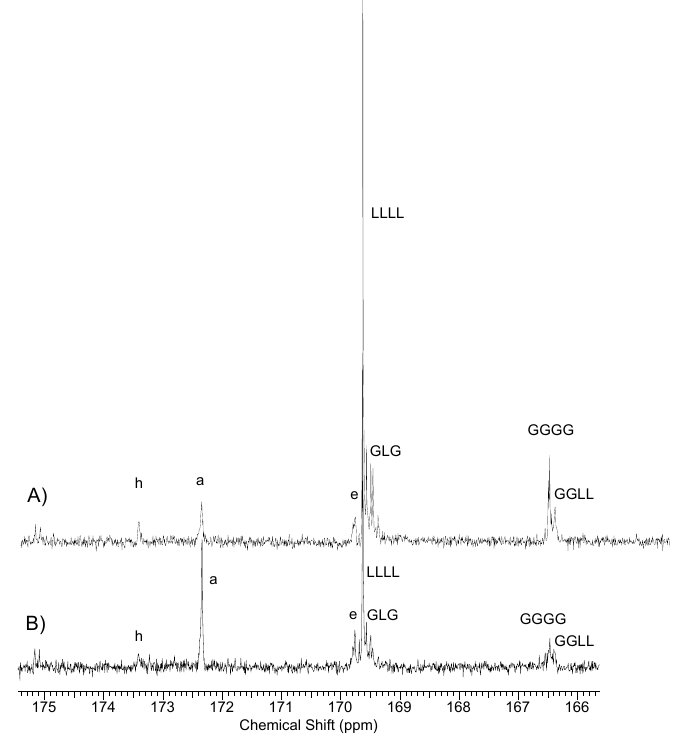
Figure 9. Spectra 13 C NMR samples of poly( L -lactide– co –glycolide)– block –poly(butylene succinate– co –butylene citrate); ( A ) sample NL15 and ( B ) sample NL 13.